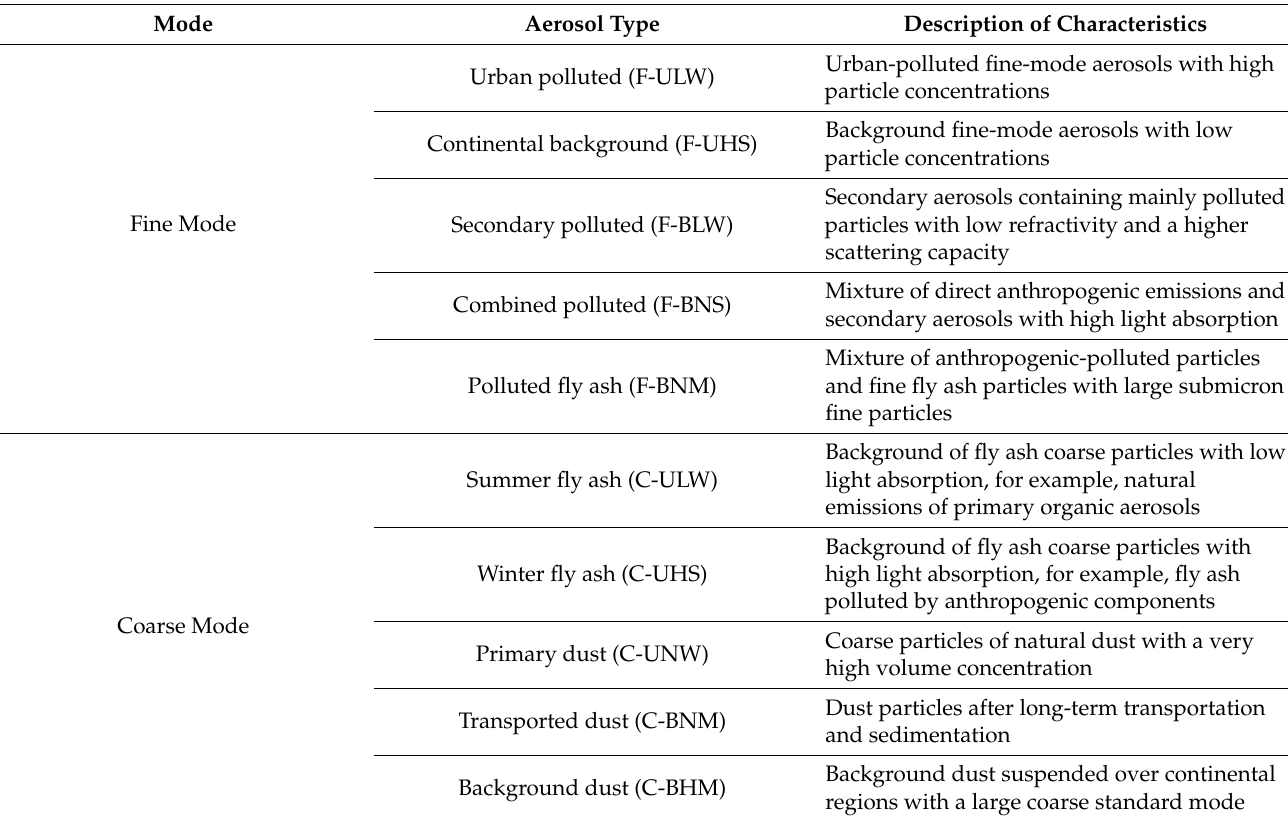
Table 3. Aerosol model classification with SONET